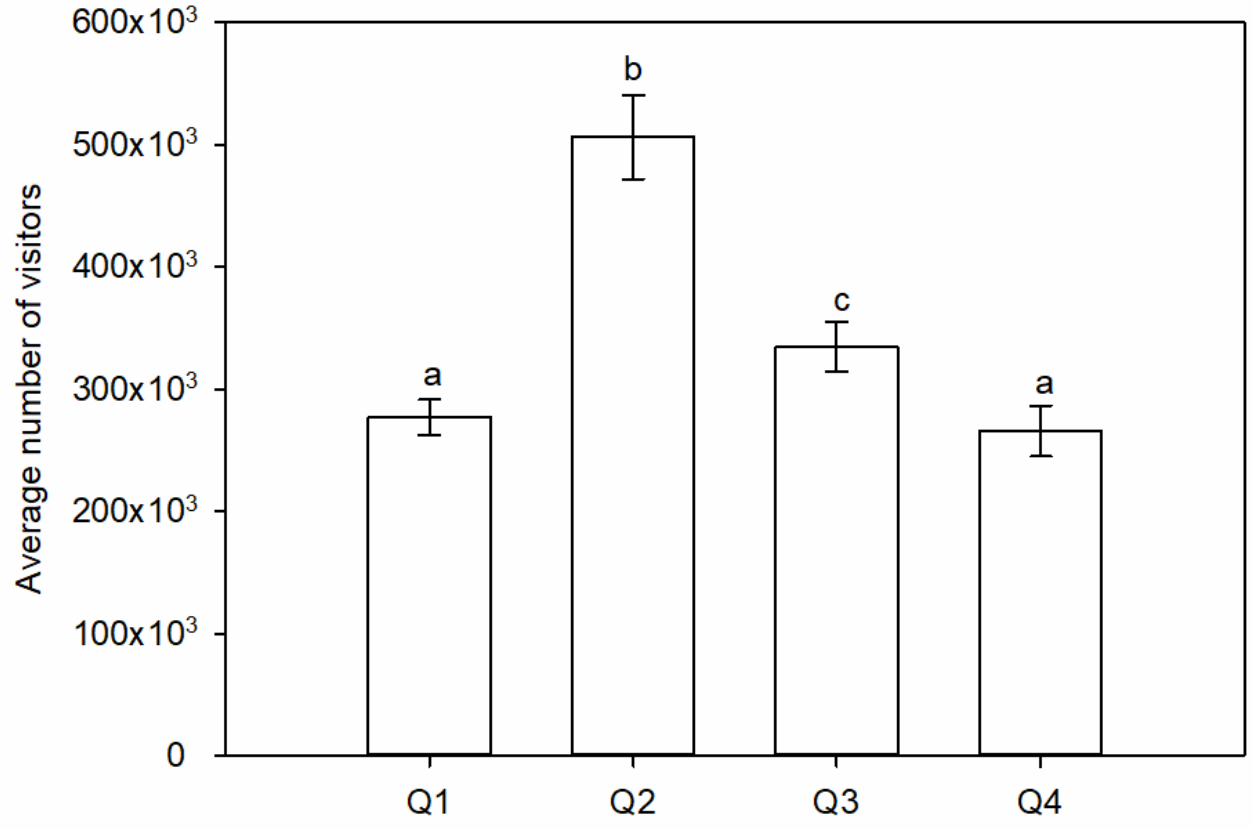
Figure 5. The quarterly average (mean ± SD, N = 4) number of visitors entering the National Museum of Marine Biology & Aquarium between 2011 and 2014. Different letters above bars indicate significant differences ( p < 0.001).